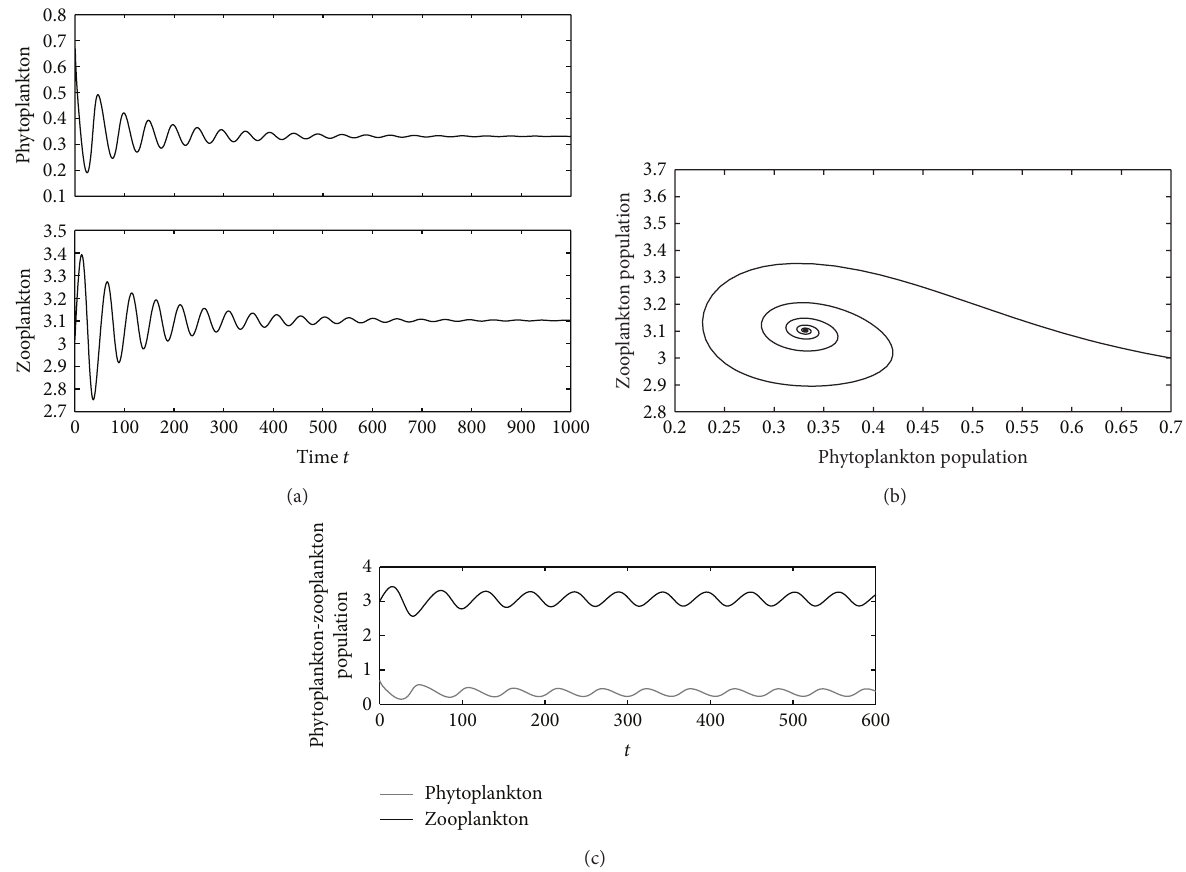
Figure 2: ((a)-(b)) Behavior and phase portrait of system (4) with 𝜏 = 0.1 < 𝜏 0 . The positive equilibrium 𝐸 ∗ 1 (0.3315, 3.1025) is stable. (c) The oscillations of 𝑃 and 𝑍 versus time 𝑡 when 𝜏 = 3.57 > 𝜏 0 show that the positive equilibrium 𝐸 ∗ 1 is unstable. Here 𝜏 0 = 3.5 and the initial value is (𝜙(0),𝜑(0)) = (0.7, 3)